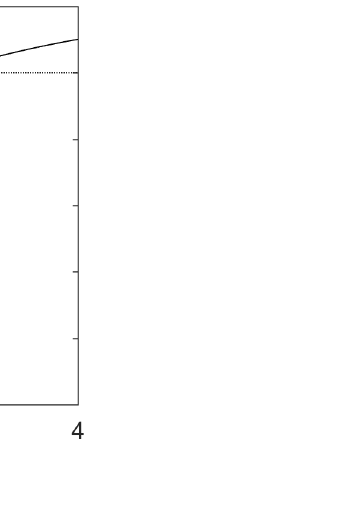
Fig 6. Lyapunov spectrum for the transformed